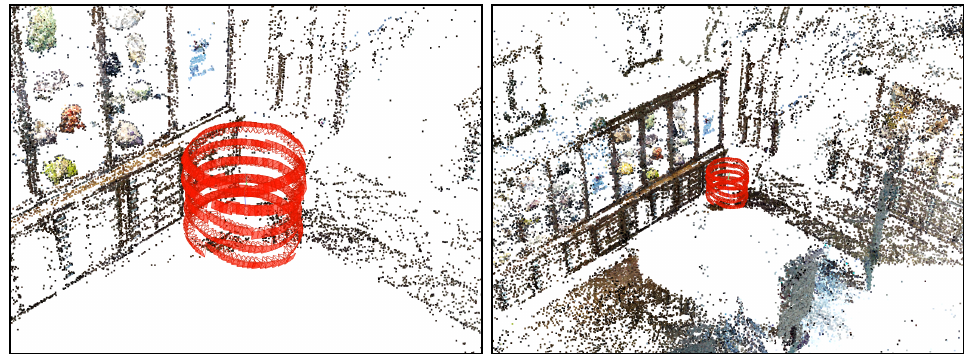
Figure 4. Reconstructing the museum scene in